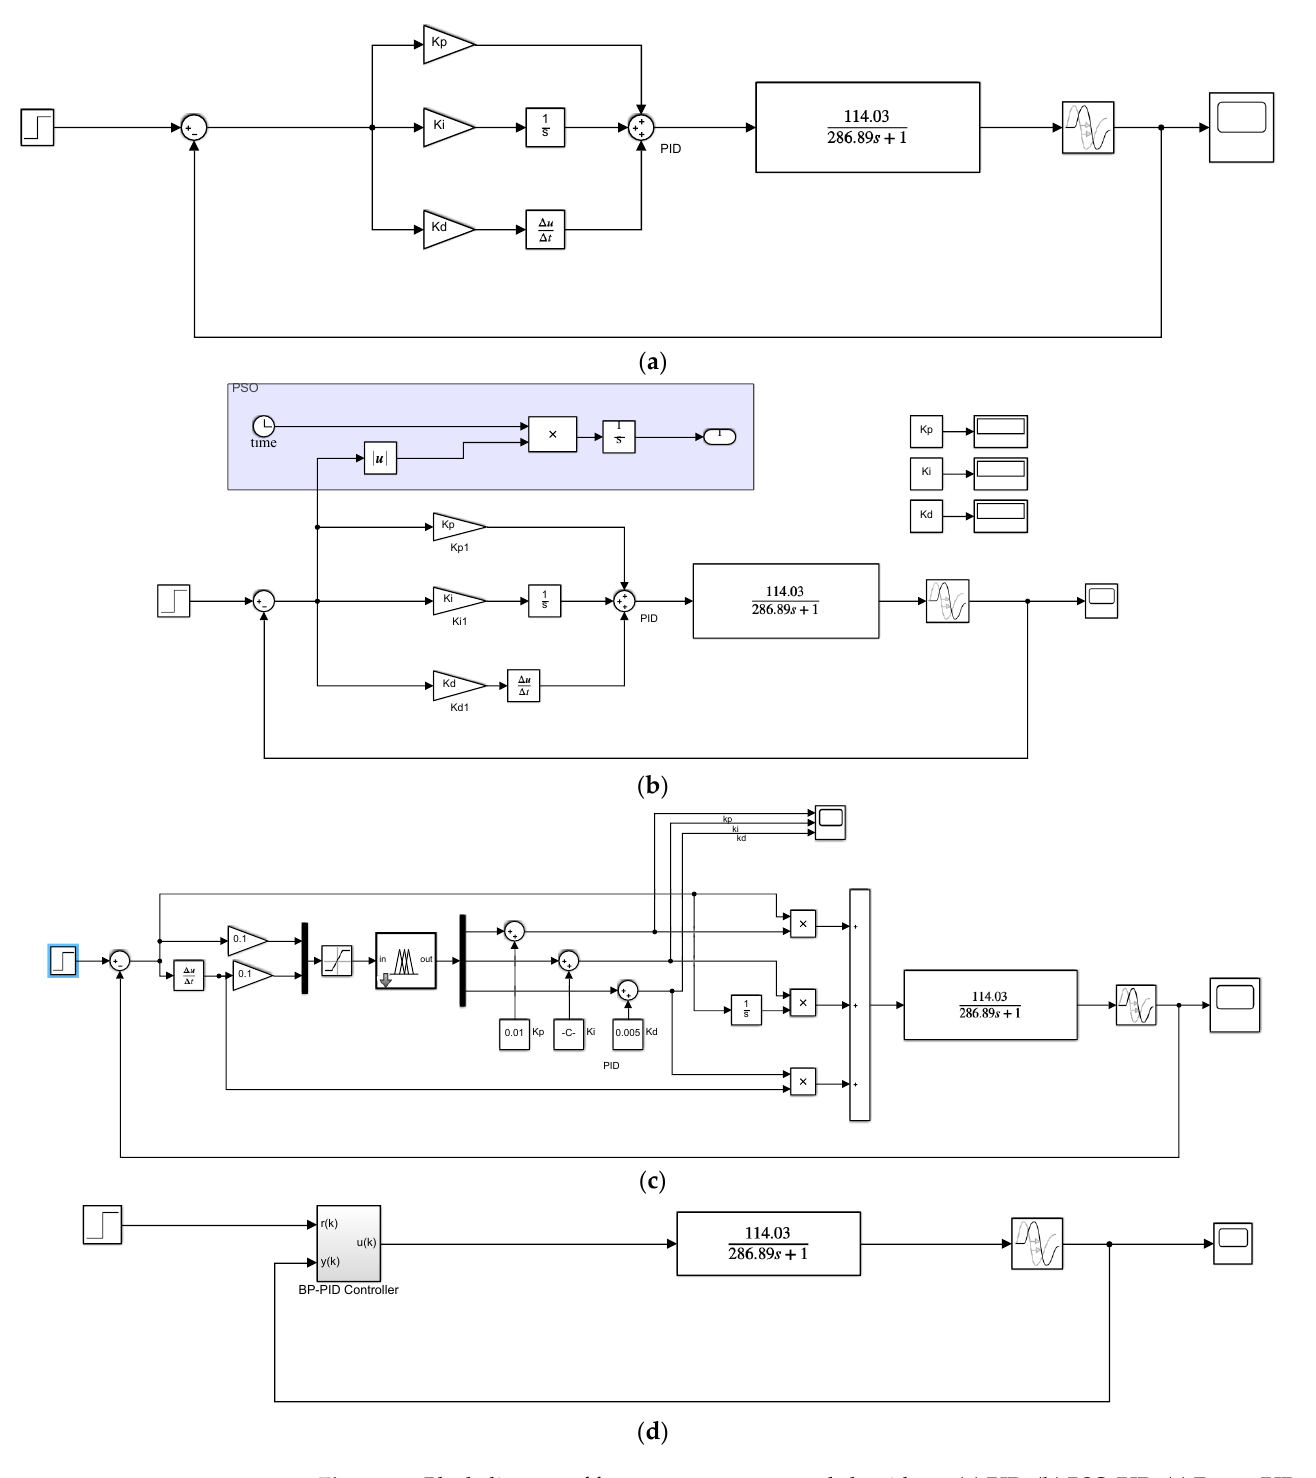
Figure 12. Block diagram of four temperature-control algorithms. ( a ) PID; ( b ) PSO-PID; ( c ) Fuzzy-PID; ( d ) BP-PID.